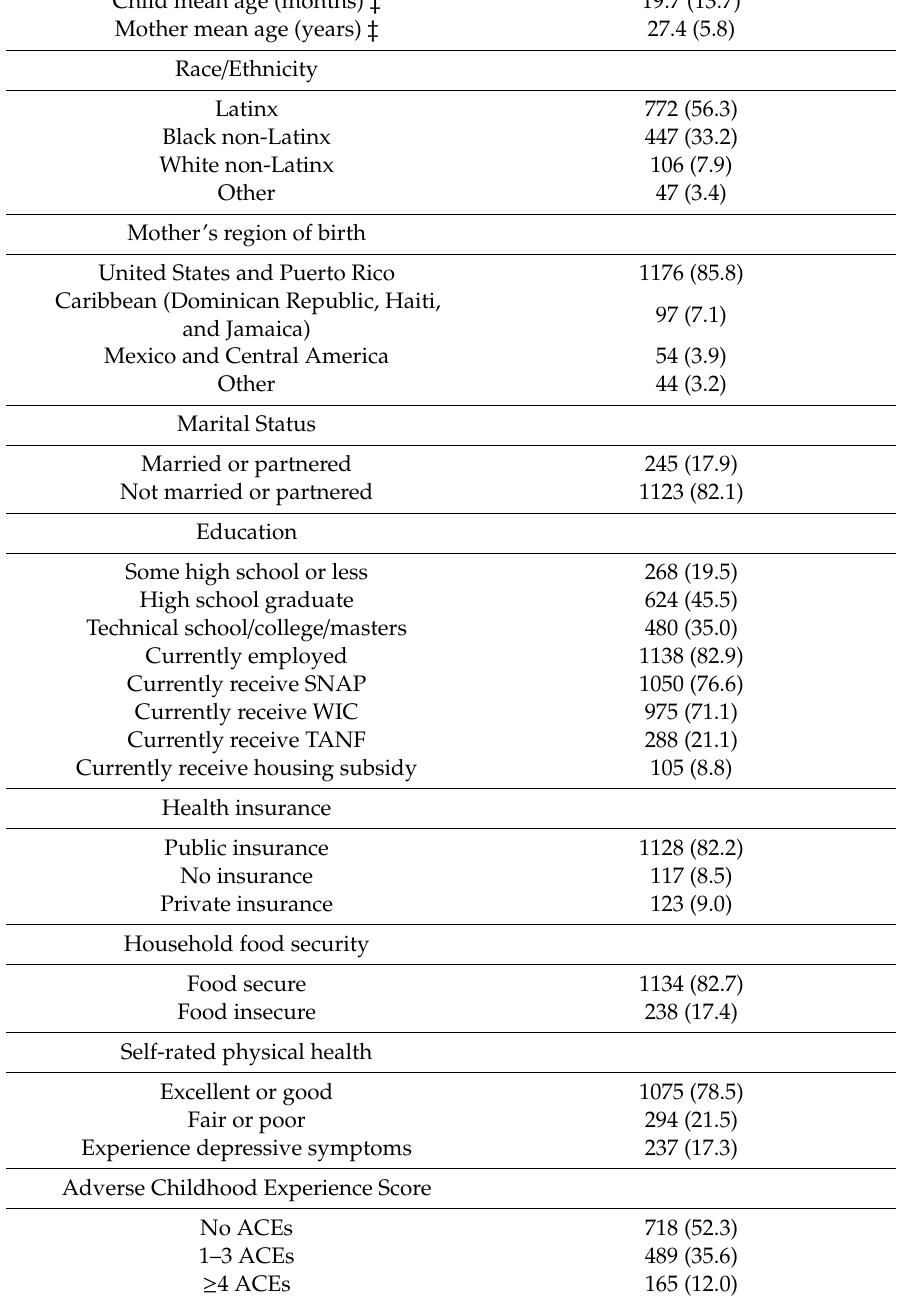
Table 1. Sample Characteristics (N = 1372)